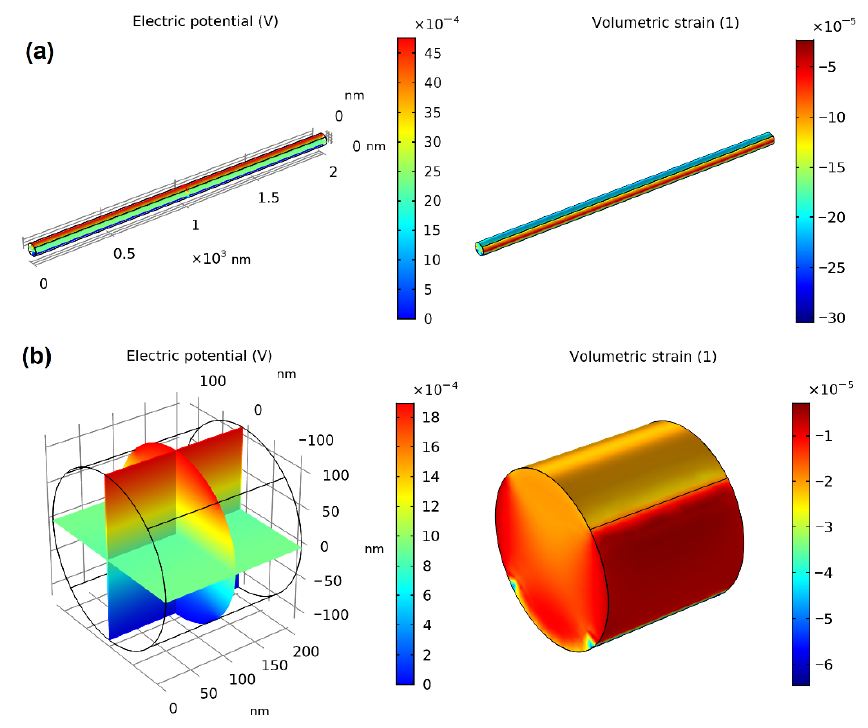
Figure 5. Simulated output voltage ( left ) and volumetric strain ( right ) of ( a ) nanofiber with average diameter of 75 nm and length of 2000 nm and ( b ) nanofiber with average diameter of 235 nm and length of 204 nm.